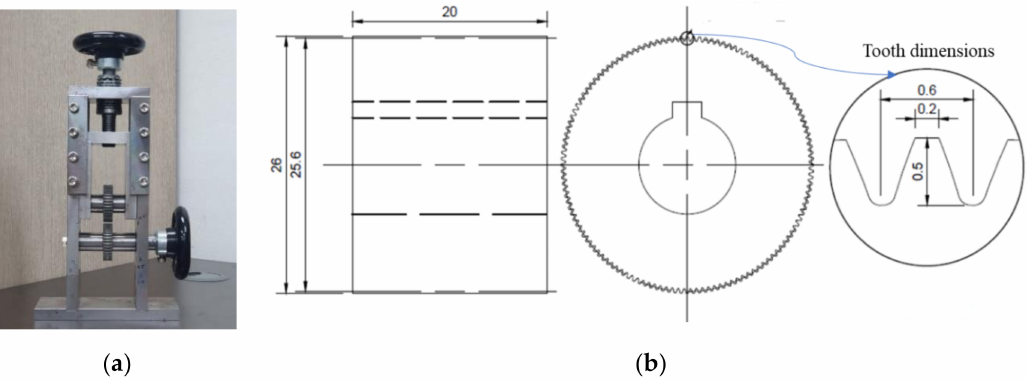
Figure 2. Rolling device with the dimension of the gear: ( a ) rolling device; and ( b ) dimension of the gear. Table 2. Dimensions of crimped fibers (unit: